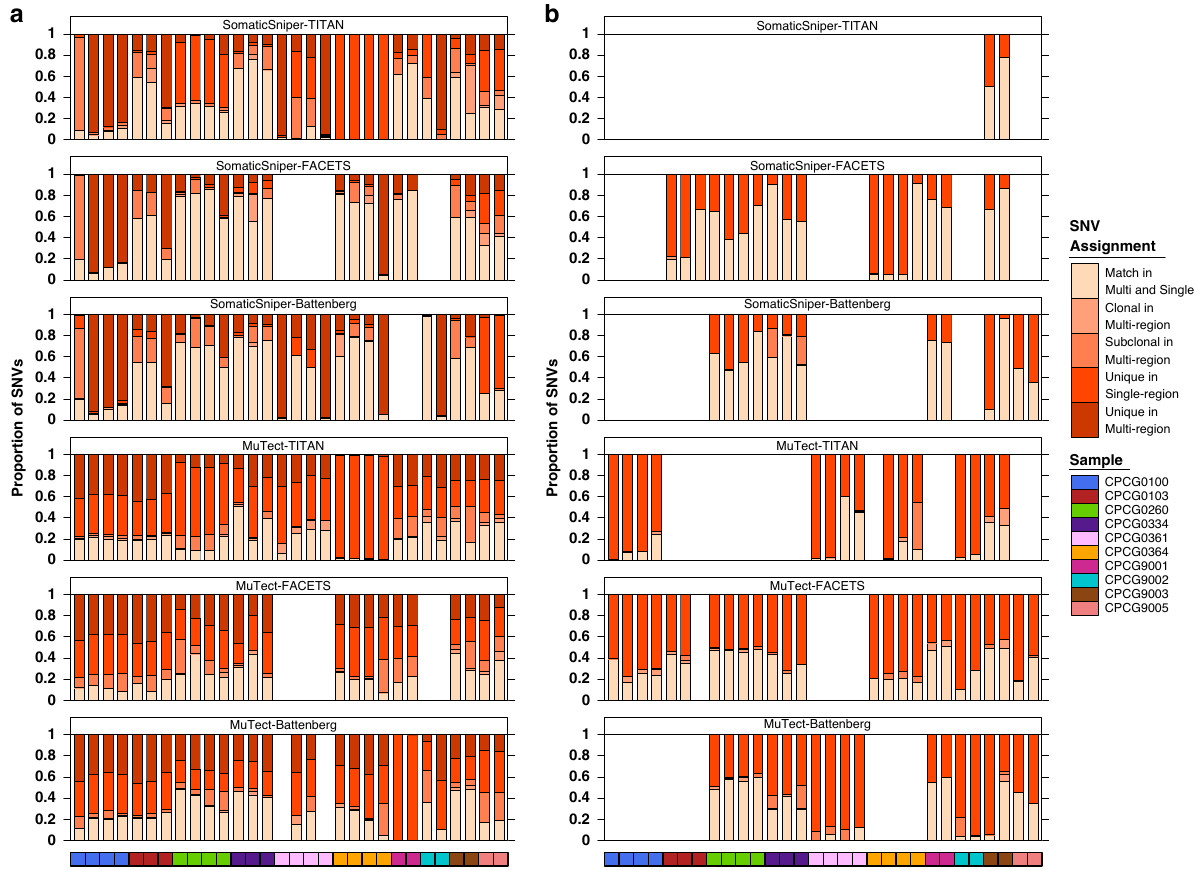
Fig. 7 SNV clonality predictions differ between single- and multi-region reconstructions. Comparison of the clonality of SNVs identi fi ed by single-region and multi-region reconstructions by pipelines using a PhyloWGS and b PyClone. Each stacked bar represents a single-region and covariate bar color indicates the identity of the sample. Missing bars indicated failed reconstructions, either single- or multi-region. SNVs were grouped into fi ve categories by color of stacked bar plot: ‘ Match in Multi and Single ’ if the SNV was predicted to be the same clonality in single- and multi-region reconstructions, ‘ Clonal in Multi-region ’ if the SNV was clonal in multi-region reconstruction but subclonal in single-region reconstruction, and ‘ Subclonal in Multi-region ’ if vice versa. If a SNV was only analyzed in single-region reconstruction, it was ‘ Unique in Single-region ’ , while SNVs only analyzed in multi-region reconstruction were ‘ Unique in Multi-region ’ . SomaticSniper-TITAN-PhyloWGS: n = 30 biologically independent samples; SomaticSniper-FACETS-PhyloWGS: n = 24; SomaticSniper-Battenberg-PhyloWGS: n = 28; MuTect-TITAN-PhyloWGS: n = 30; MuTect-FACETS-PhyloWGS: n = 24; MuTect-Battenberg-PhyloWGS: n = 28. SomaticSniper-TITAN-PyClone: n = 2; SomaticSniper-FACETS-PyClone: n = 18; SomaticSniper-Battenberg-PyClone: n = 13;